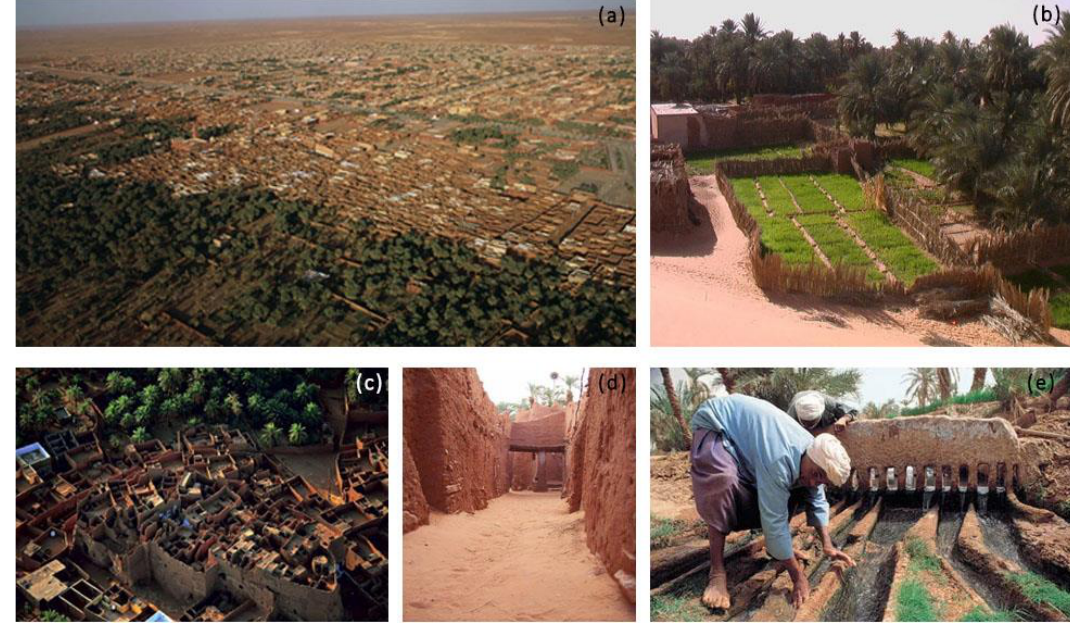
Figure 6 (a) The general landscape of Timimoun, (b) Palm groves and orchards, (c) Ksar , (d) the streets of Ksar , (e) Foggara system and water distribution shaft